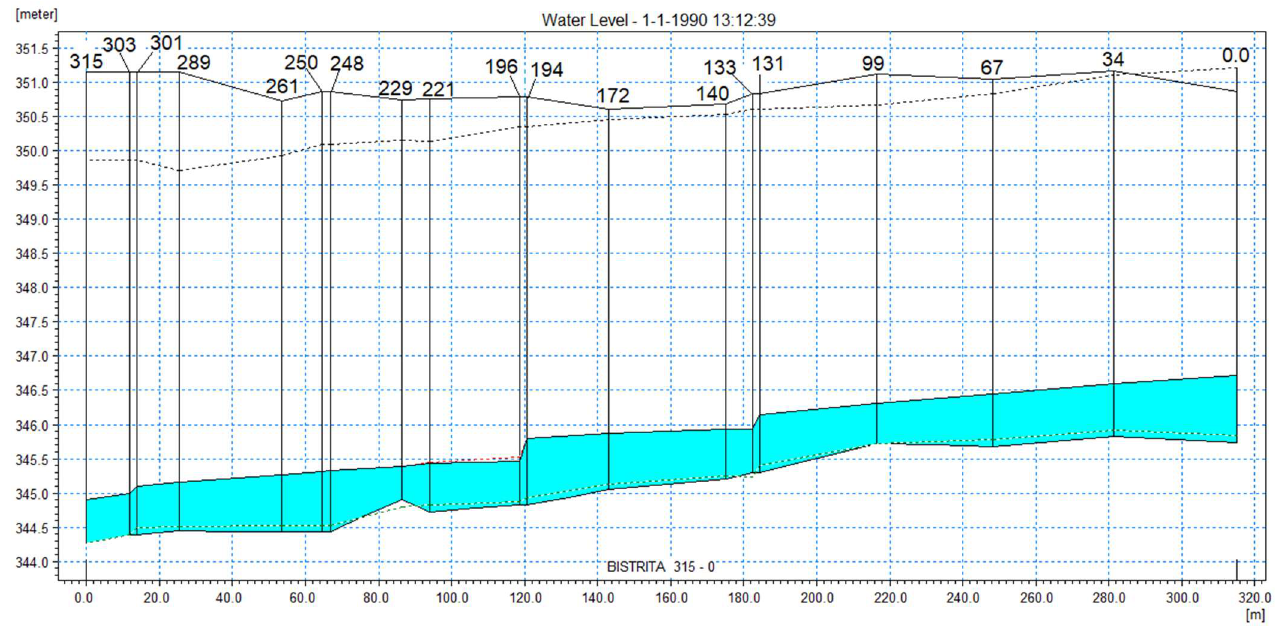
m 3 /s. Q = 8.37 m 3 /s.